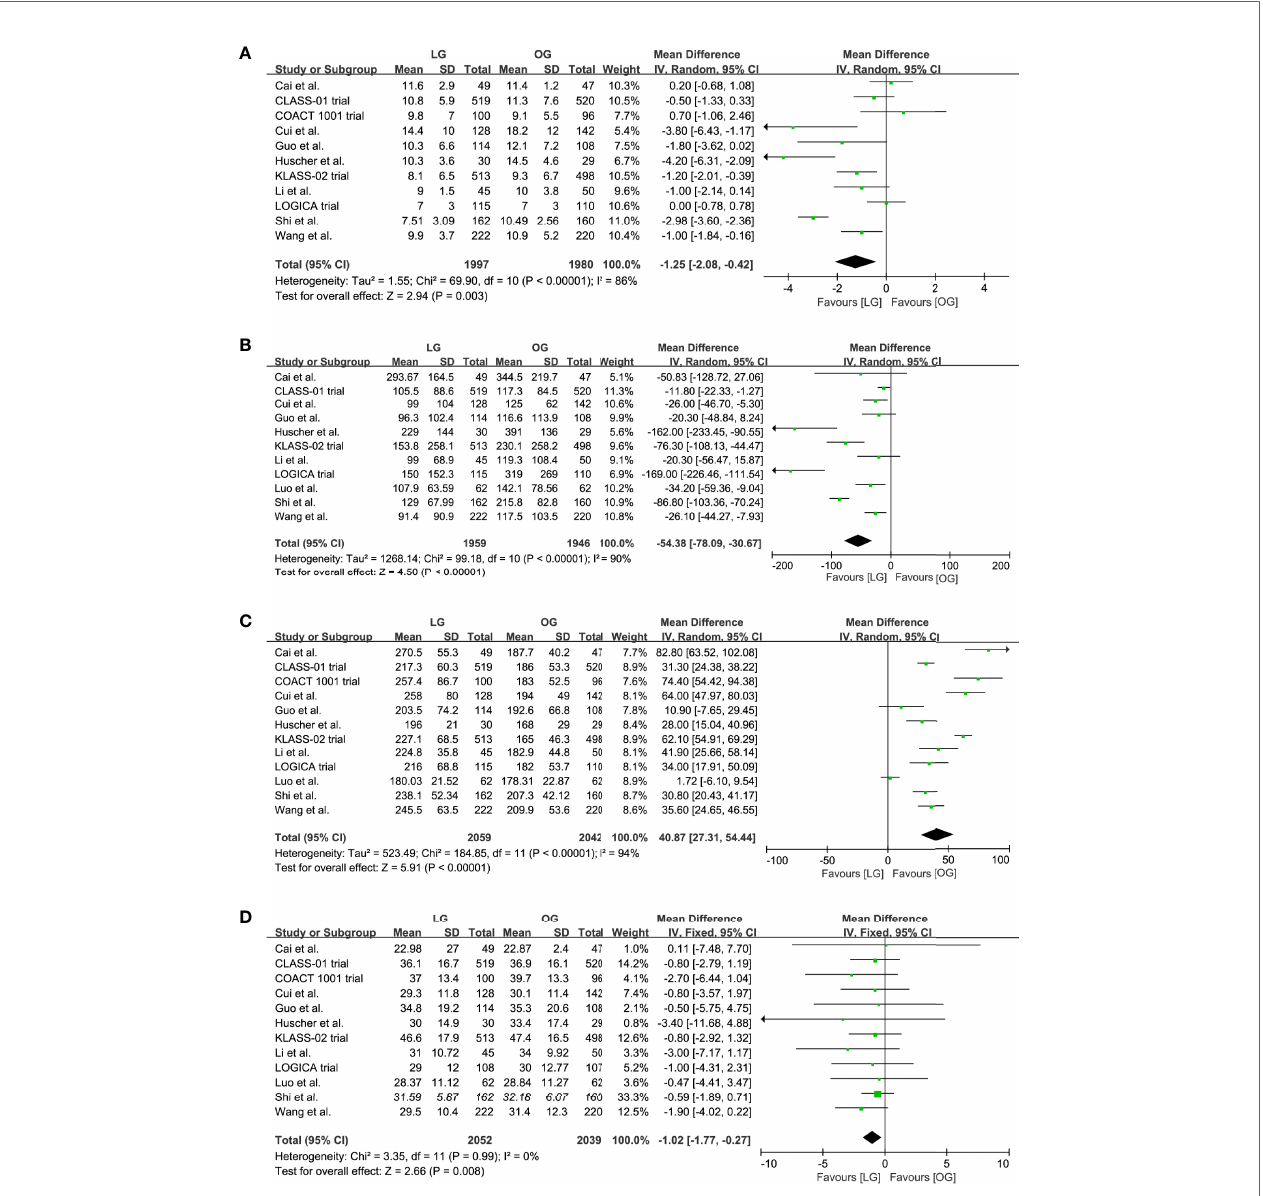
FIGURE 4 | Pooled estimates of (A) length of hospital stay, (B) blood loss, (C) surgical time, (D) number of retrieved lymph